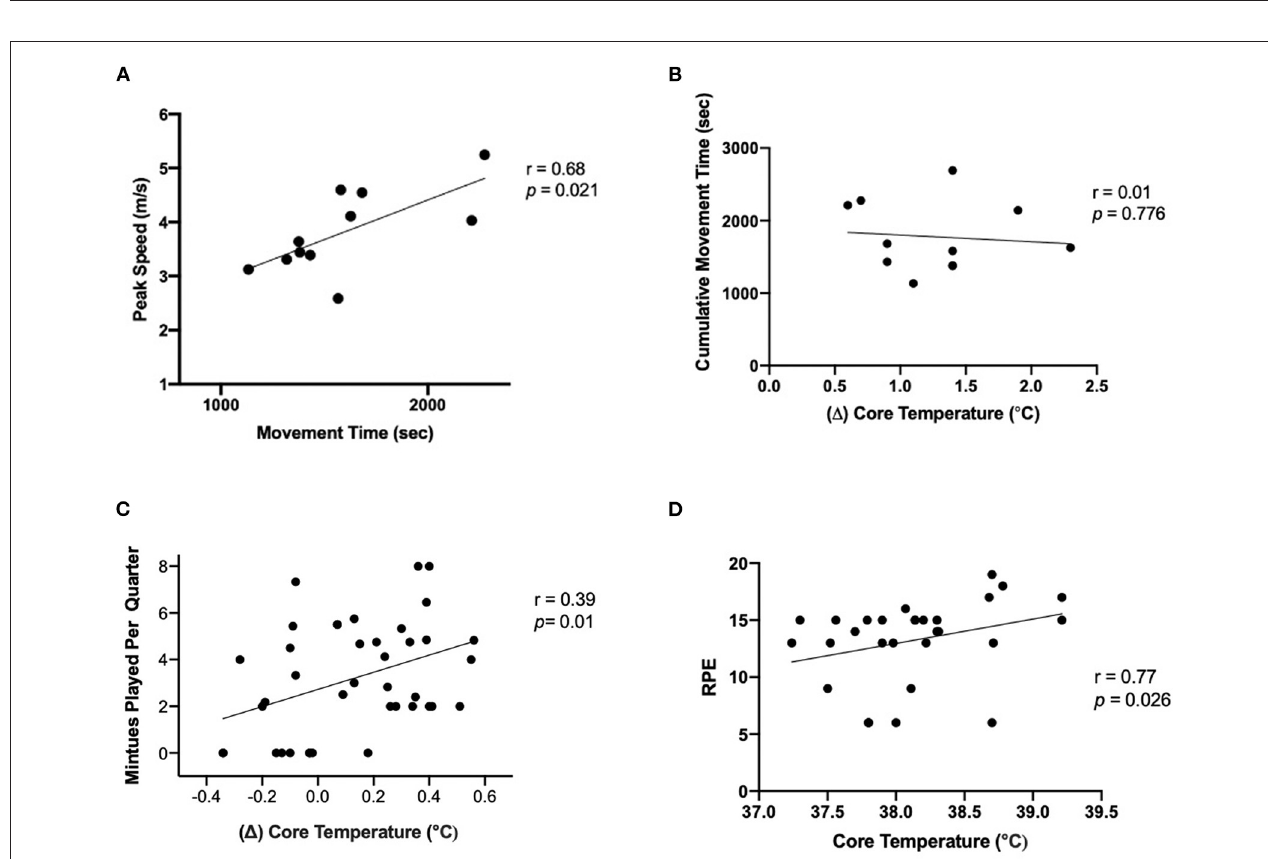
FIGURE 4 | (A) correlation between peak speed (m/sec) and movement time, (B) correlation of mean ( 1 ) of gastrointestinal temperature and cumulative movement time (sec), (C) correlation of mean change ( 1 ) of gastrointestinal temperature ( ◦ C) and playing time per Q (mins), and (D) correlation of gastrointestinal temperature ( ◦ C) and RPE